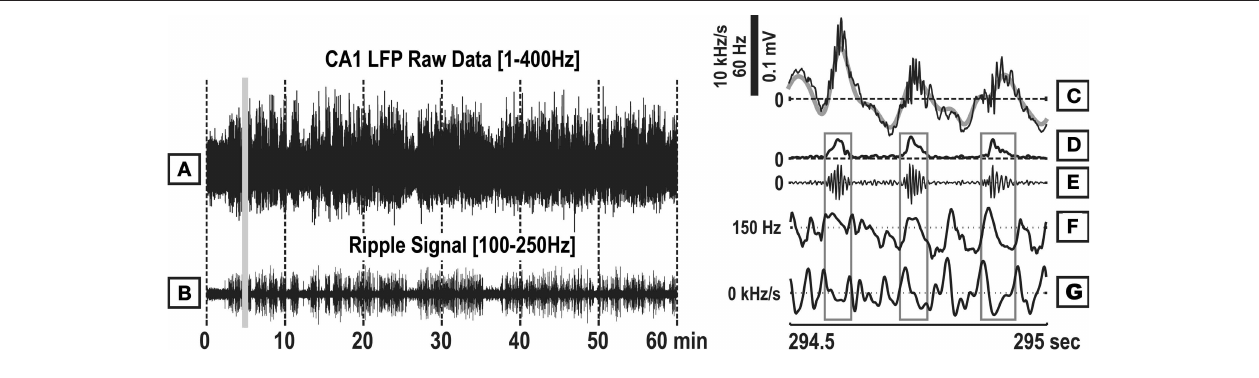
FIGURE 1 | Illustration of signal processing. (A) LFP recording from stratum oriens of the dorsal CA1 region, sampled at 800 Hz. (B) Bandpass fi ltered LFP signal between (100–250 Hz) results in typical “ripple” signal. (C) Snapshot of raw LFP data taken from (A) (grey vertical bar), with